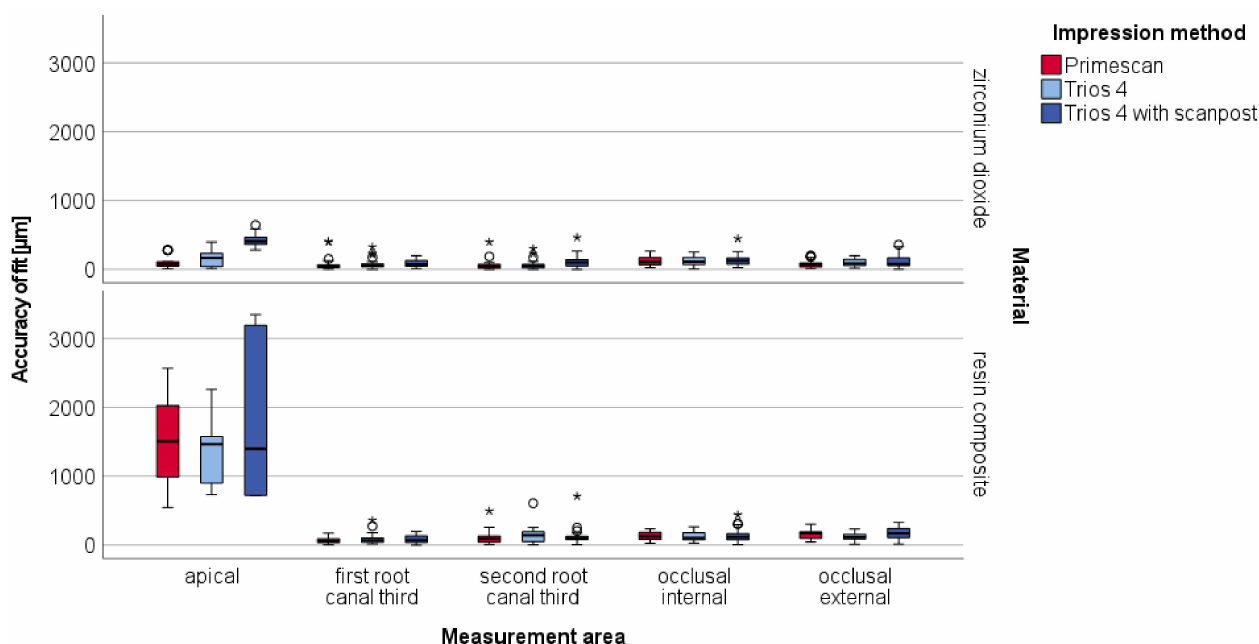
Figure 8. Boxplot diagram of the linear discrepancies ( µ m) distributed to the five measurement areas for fabricated CAD/CAM-P+C milled of zirconium dioxid and resin composite based on digital impressions with IOS; outliners (O), extreme values (*).